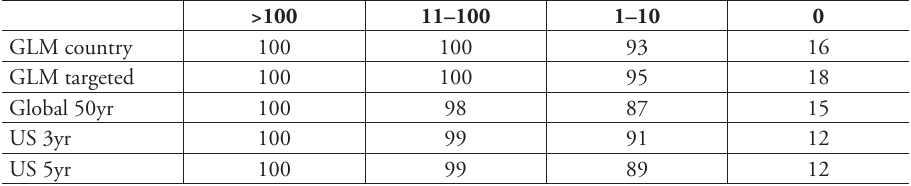
Table 1. Model correct classification by coypu density class. Numbers represent the percent of sub-water- sheds (Hydrologic Unit Code 12s) in Washington and Oregon classified as suitable by each model (general- ized linear models [GLM]; row) and coypu density class (>100, 11–100, 1–10, and 0 individuals; column).